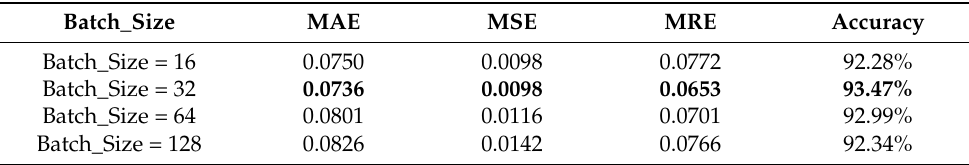
Table 4. Effects of Batch_Size at A 1 .